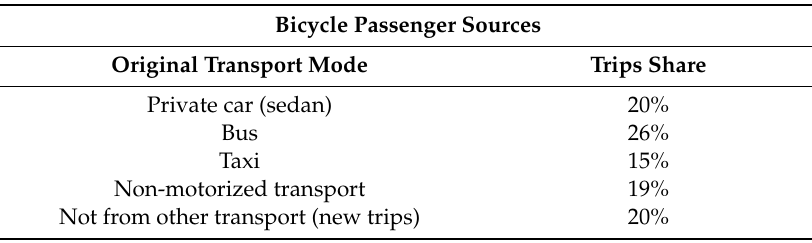
Table 7. Bicycle passenger sources by transport